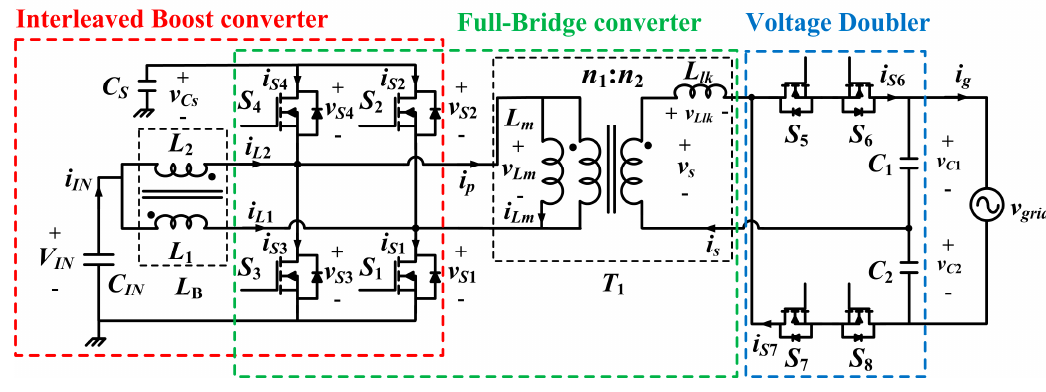
Figure 1. The circuit structure of the proposed micro-inverter.